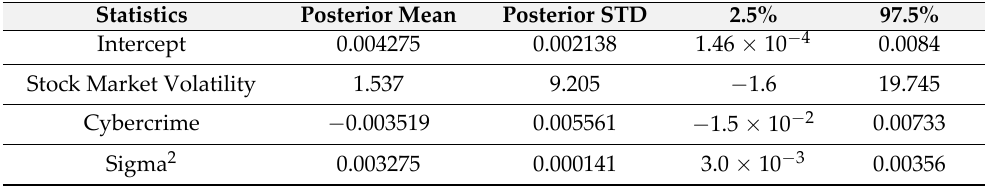
Table 2. BLR results with Return on BNB as dependent